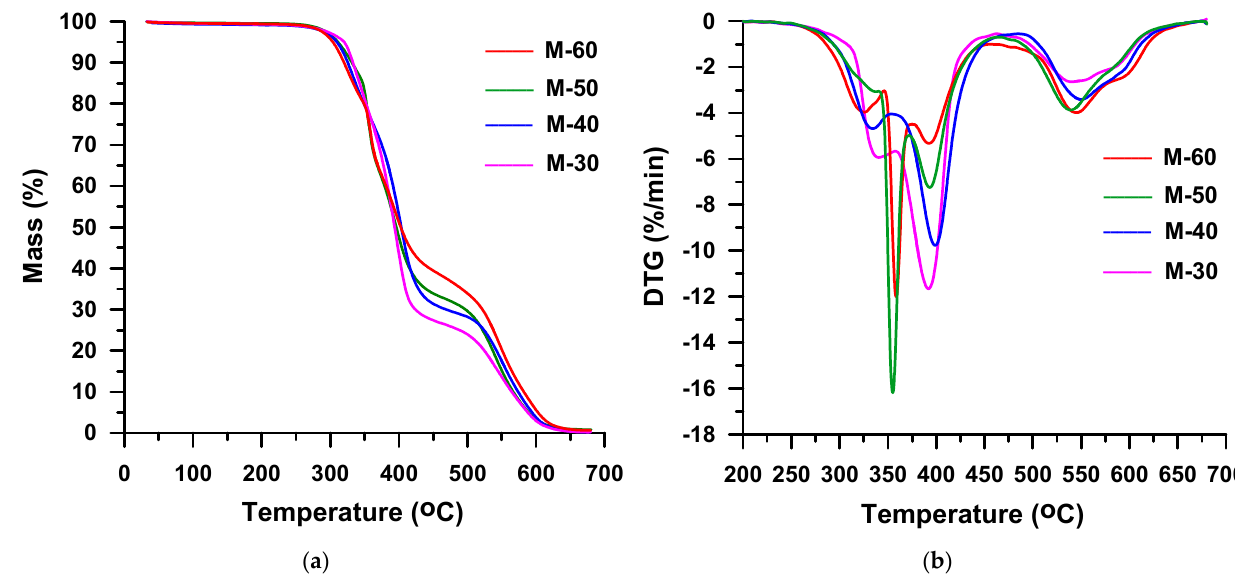
Figure 13. TG ( a ) and DTG ( b ) curves of the MDI-based TPU elastomers obtained in air.